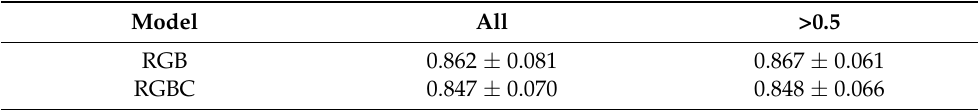
Table 5. Mean IoU values of the correctly identified crowns.